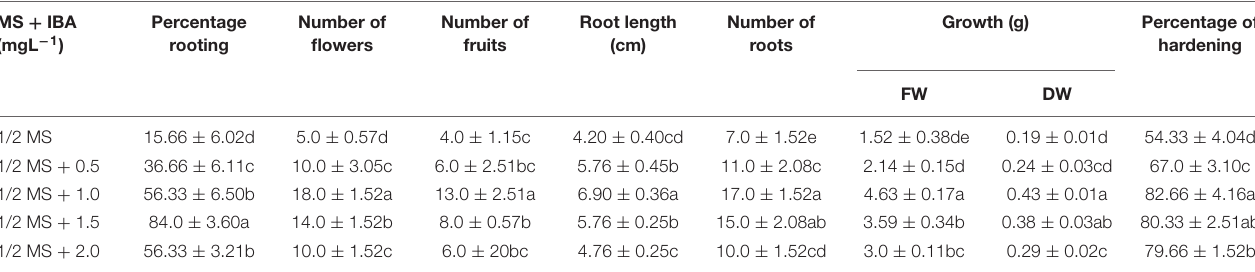
TABLE 4 | Effect of different combinations of IBA on in vitro flowering and rooting responses in Withania somnifera